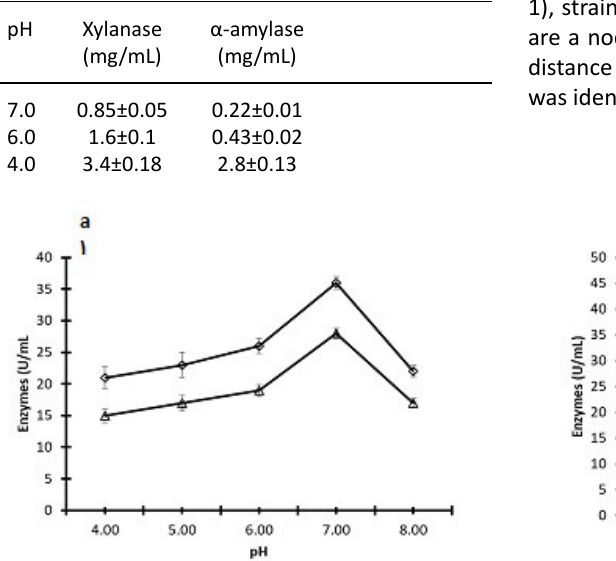
Table 1. Km values (mg/mL) of xylanase and α-amylase enzymes produced from Pichia membranifaciens at different pH values. The data were considered as means ± S.E. (n=3)